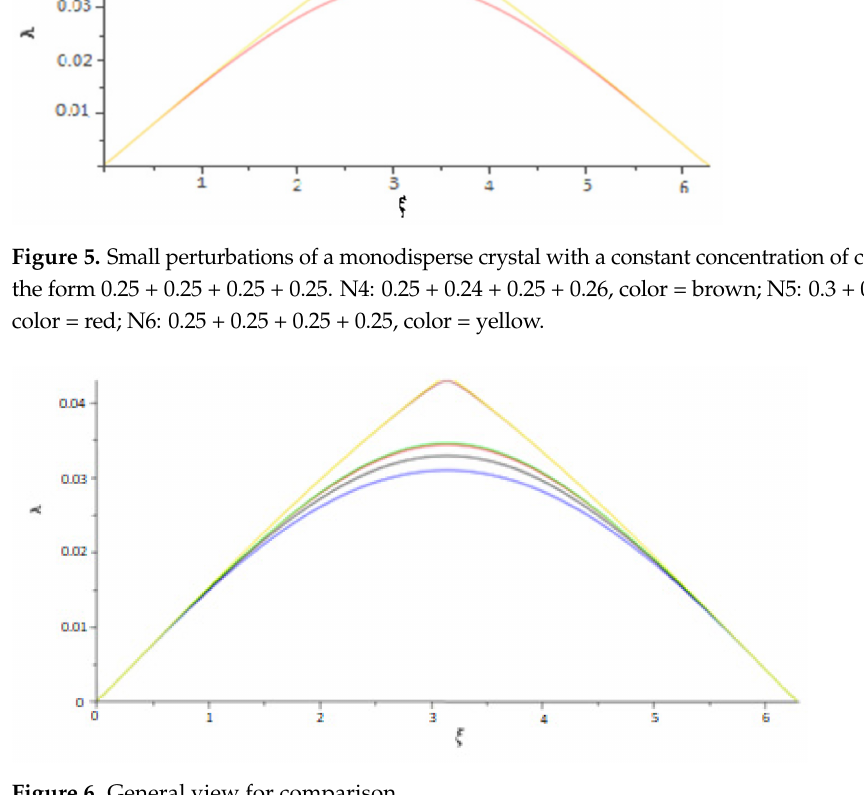
Figure 6. General view for